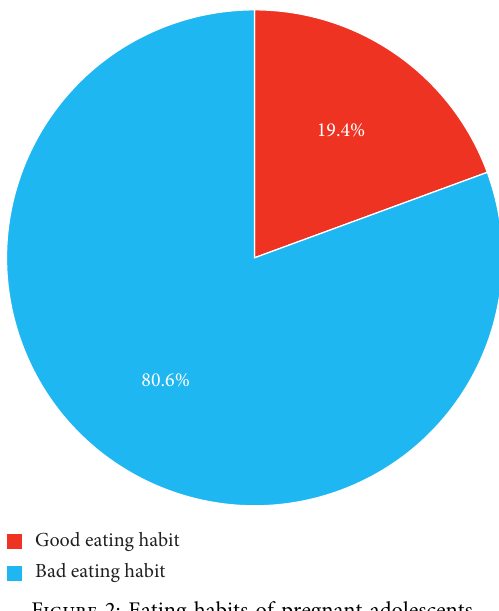
Figure 2: Eating habits of pregnant adolescents.